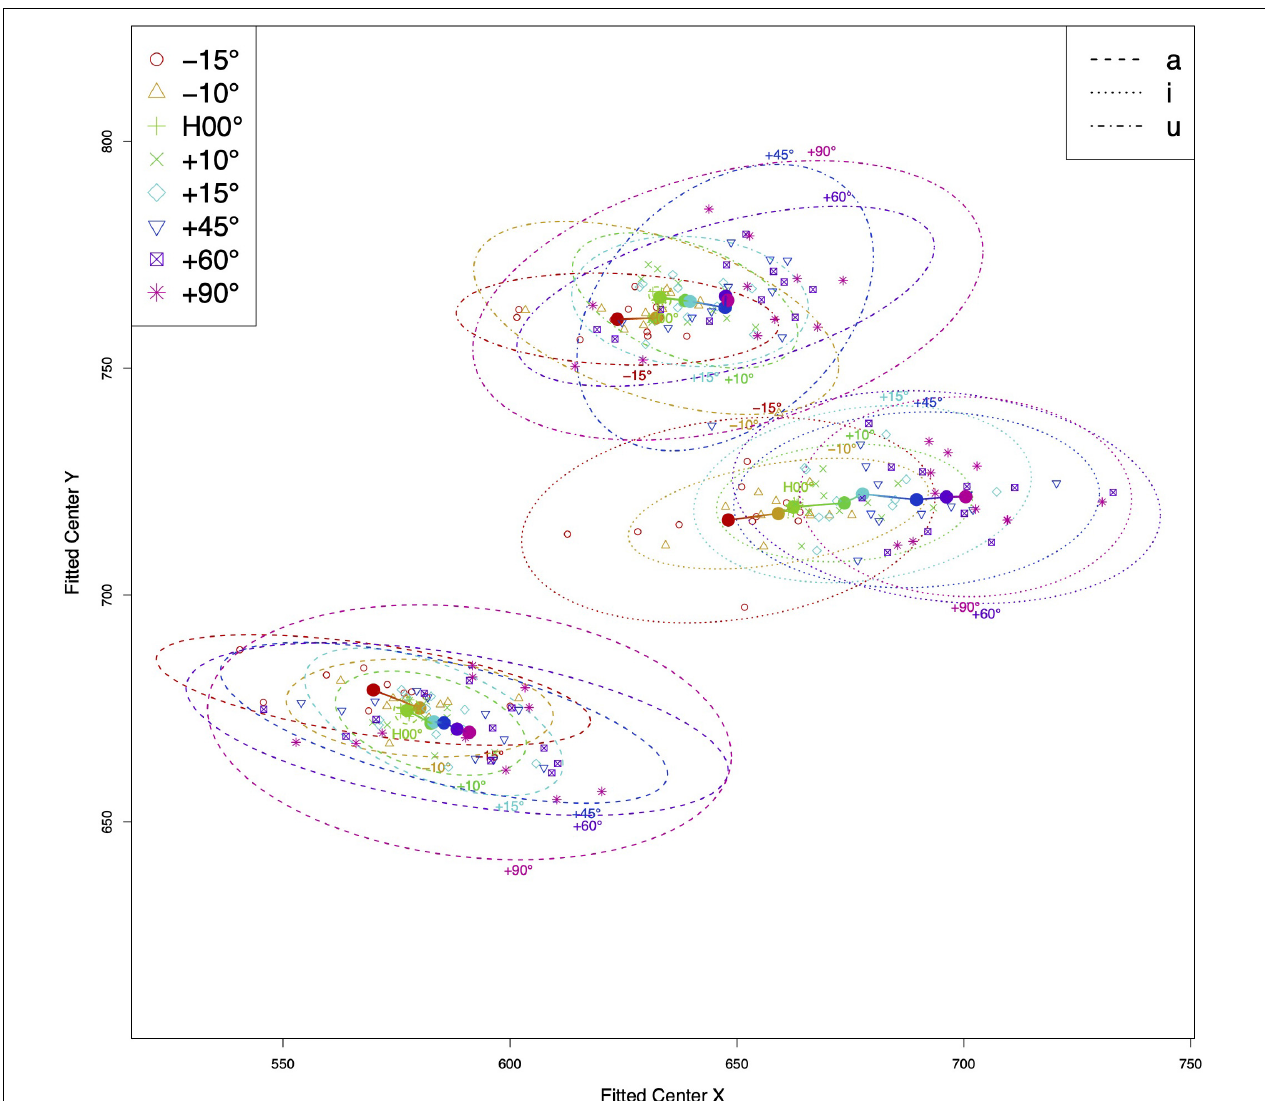
FIGURE 3 | Averaged tongue centers across different head angles (color-coded) for all three vowels (line type separated). Hollow circles represent the averaged tongue center for individual speakers; solid circles represent the averaged tongue centers across all speakers at each head angle. Ellipses enclose 95% of the normal probability density function (color